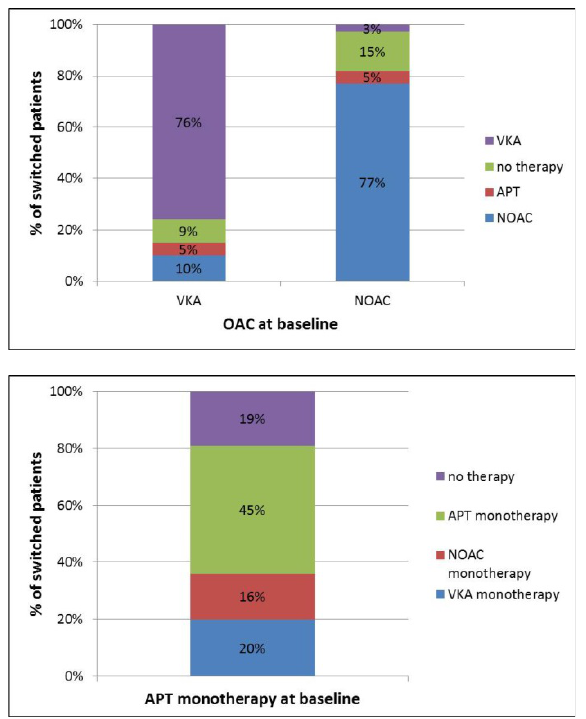
Switch in antithrombotic treatment